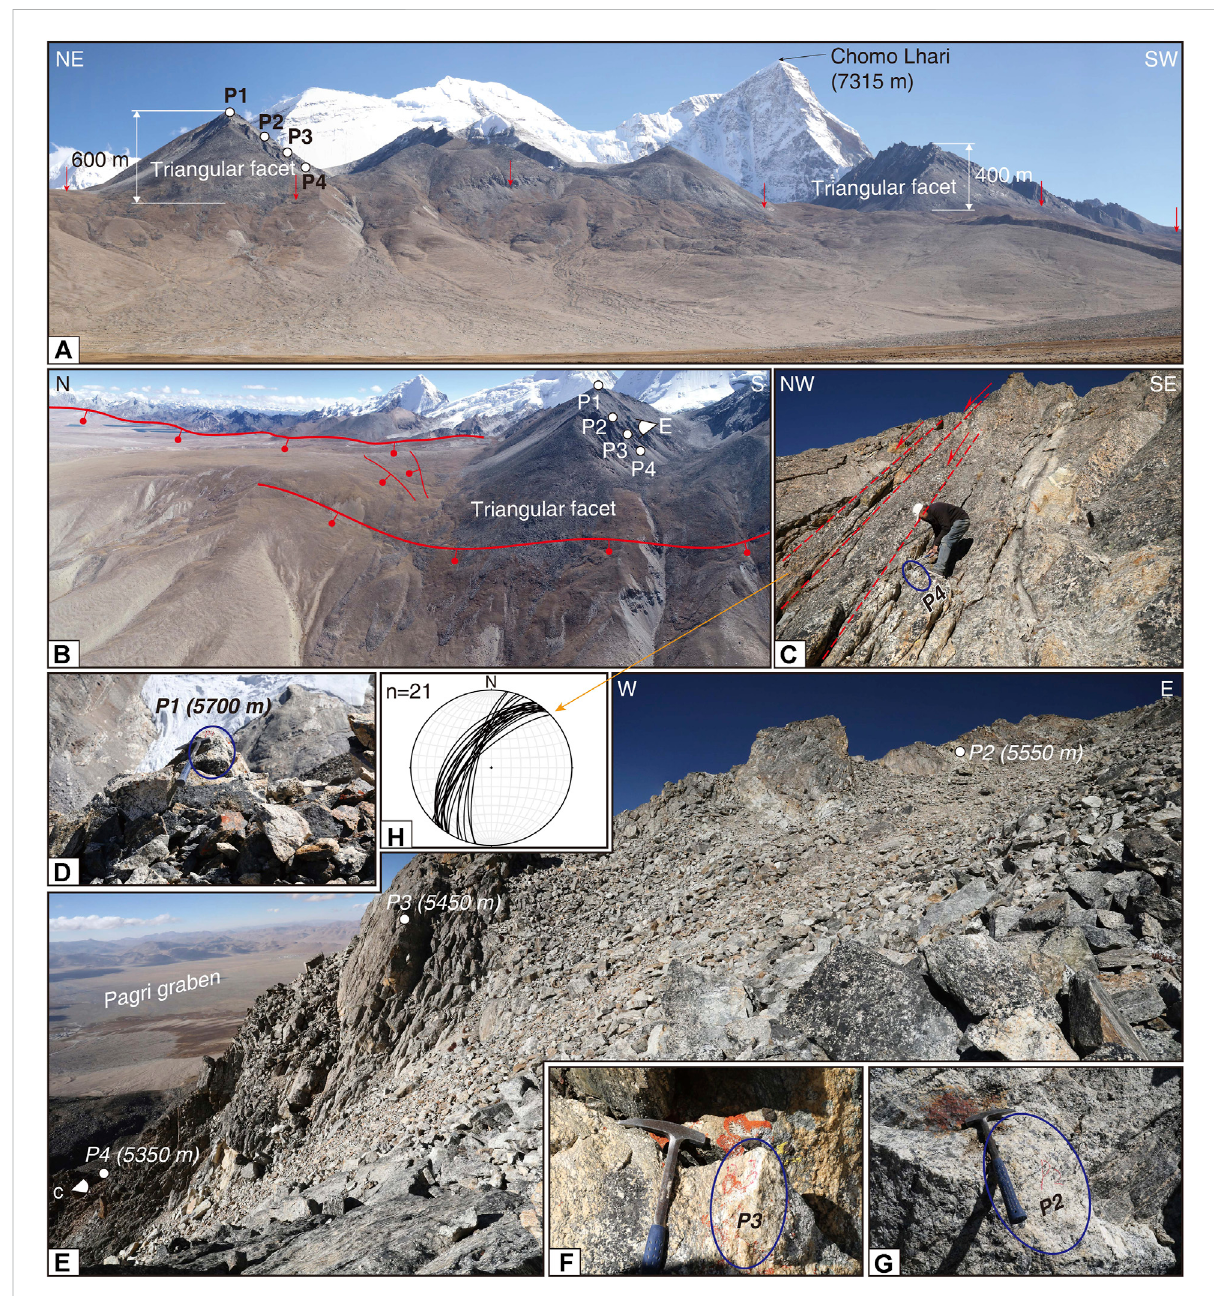
FIGURE 3 Field photos of active normal faults north of Chomo Lhari Mountain along southernmost YGR and location of samples P1 – P4. (A) Triangular facets along YGR active normal faults and location of samples P1 – P4. Red arrow refers to the active Yadong normal fault. Note Chomo Lhari peak (7,315 m) in the background. (B) Unmanned aerial vehicle (UAV) photo of samples P1 – P4 and active normal faults. (C) Outcrop of sample P4 and brittle normal fault. (D – G) Outcrop and location with elevations of samples P1 (5,700 m), P2 (5,550 m), P3 (5,450 m), and P4 (5,350 m). (H) Foliations in the YGR normal fault north of Chomo Lhari Mountain, indicating the high-angle of active normal